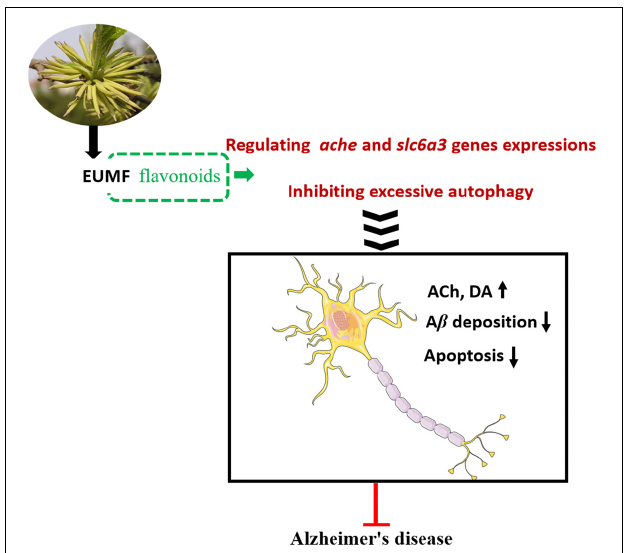
FIGURE 7 | The proposed mechanism underlying the anti-AD effect of EUMF. EUMF inhibits the excessive autophagy and abnormal expressions of the ache and slc6a3 genes to exert the therapeutic effects against AD-like symptoms. Flavonoids in EUMF may contribute to this biological